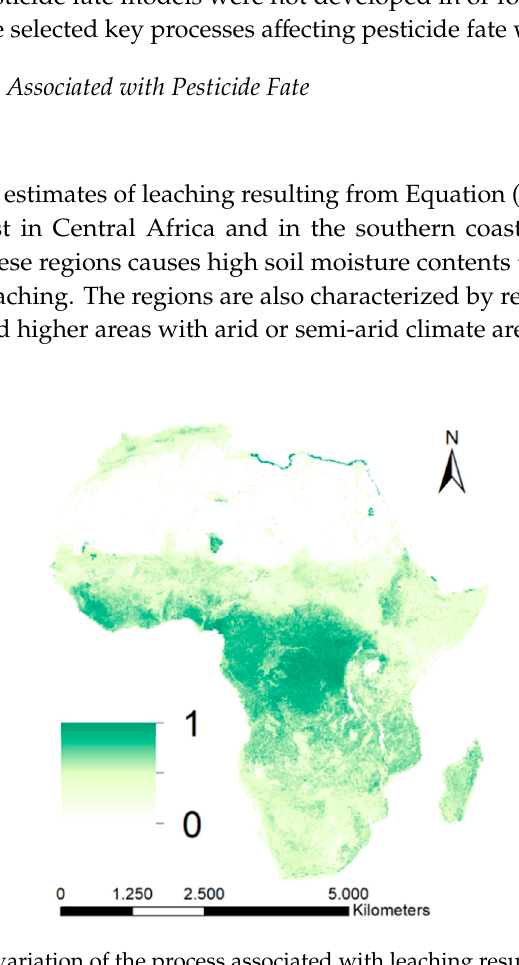
Figure 3. Geospatial variation of the process associated with leaching resulting from Equation 1.